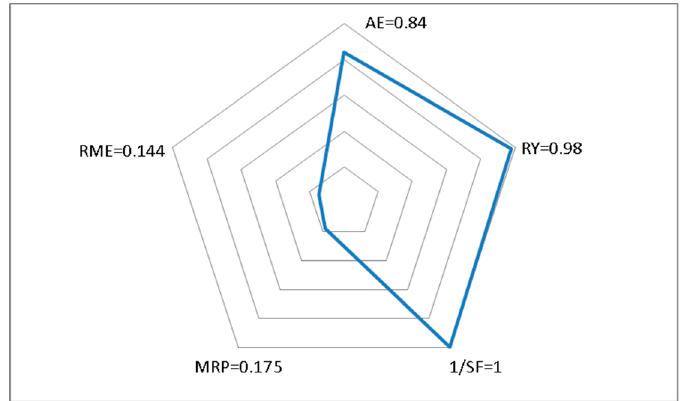
Figure 8. Radial pentagon for the tandem reaction in chromene–pyrrole synthesis.